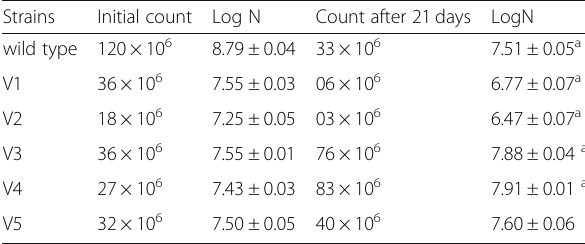
Table 2 The counts of the wild type of B. amyloliquefacience s and the variants at initial and after 21 days incubation. ( p =